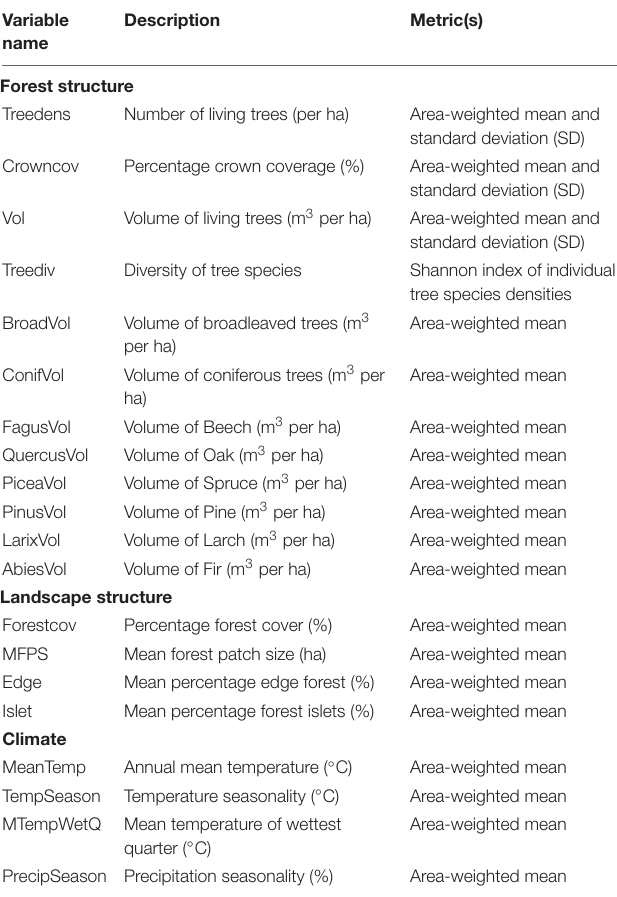
TABLE 2 | Predictor variables depicting forest structure, landscape structure, and climate used as candidates in the niche modeling